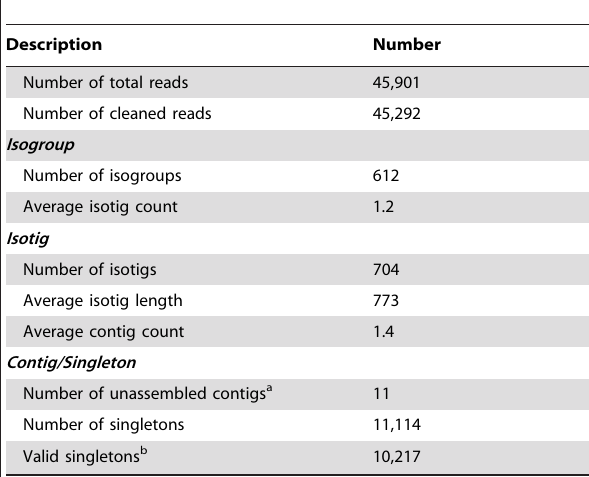
Table 1. Summary of pyrosequencing